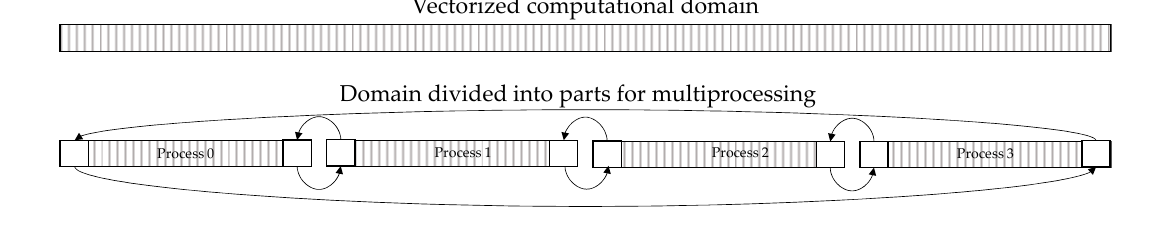
Figure 4. Visualization of multiprocessing.